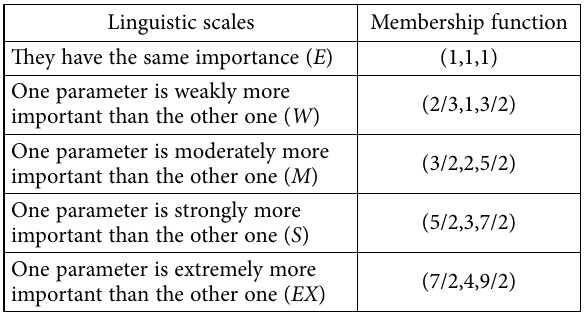
Table 1. Linguistic variables for comparing the importance